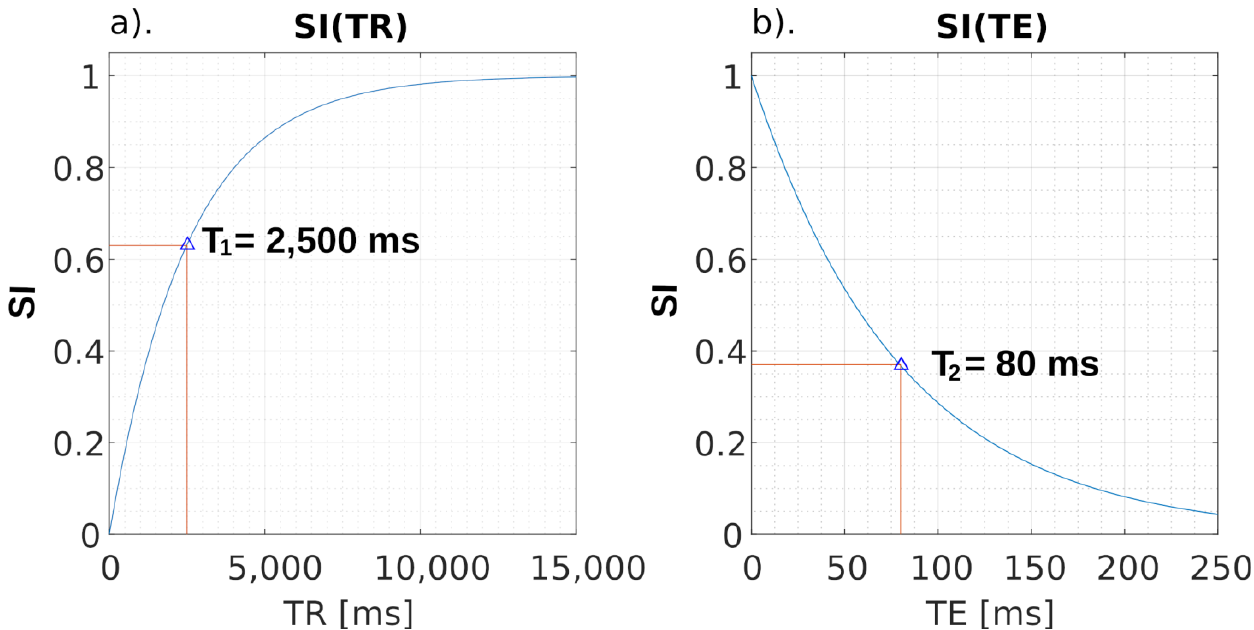
Figure 1. The graphs show the shape of the signal intensity for ( a ) longitudinal relaxation time T 1 and ( b ) transverse relaxation time T 2 . For time T 1 , it is a graph of SI as a function of repetition time TR, while for time T 2 , the graph presents SI as a function of echo time TE. The presented graphs are digitally generated waveforms to illustrate the phenomena themselves and the relationships between them. In the drawings, the points at which T 1 and T 2 were determined are marked with a triangle sign, i.e., these are the times for which SI is 63% and 37% of the maximum value of the signal, respectively.